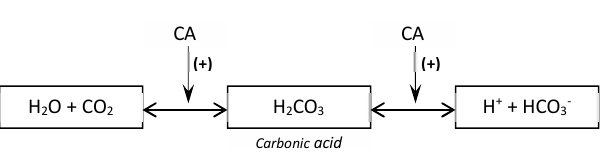
Acetazolamide is the older drug in this class of therapeutic agents and is a non-selective CA-inhibitor, whereas the newer agents are more specific to the type II isozyme. Mannitol, a systemic CAI (carbonic acid anhydrase inhibitor) may be used intravenously to achieve short-term ocular hypotensive effects.